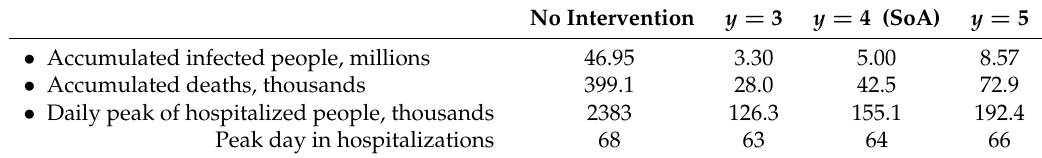
Table A2. Simulation results of the intensity of social distancing in Spain.